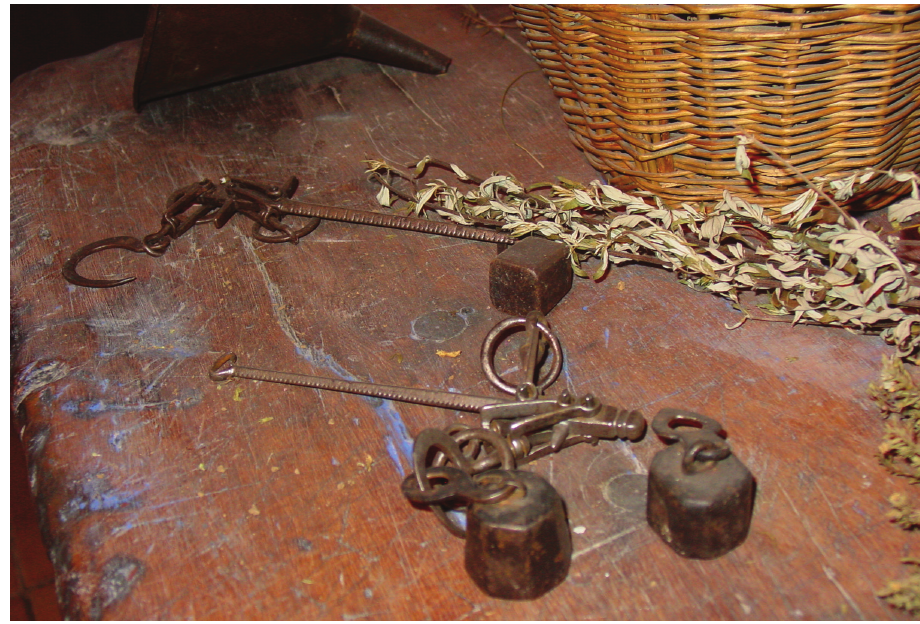
Figure 4: Portable romana © Museu de les Trementinaires, Tuixent, Lleida,